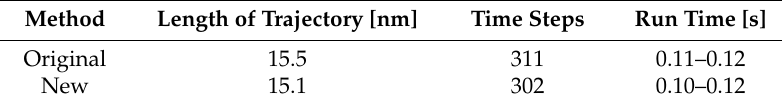
Table 8. Results comparison for the two